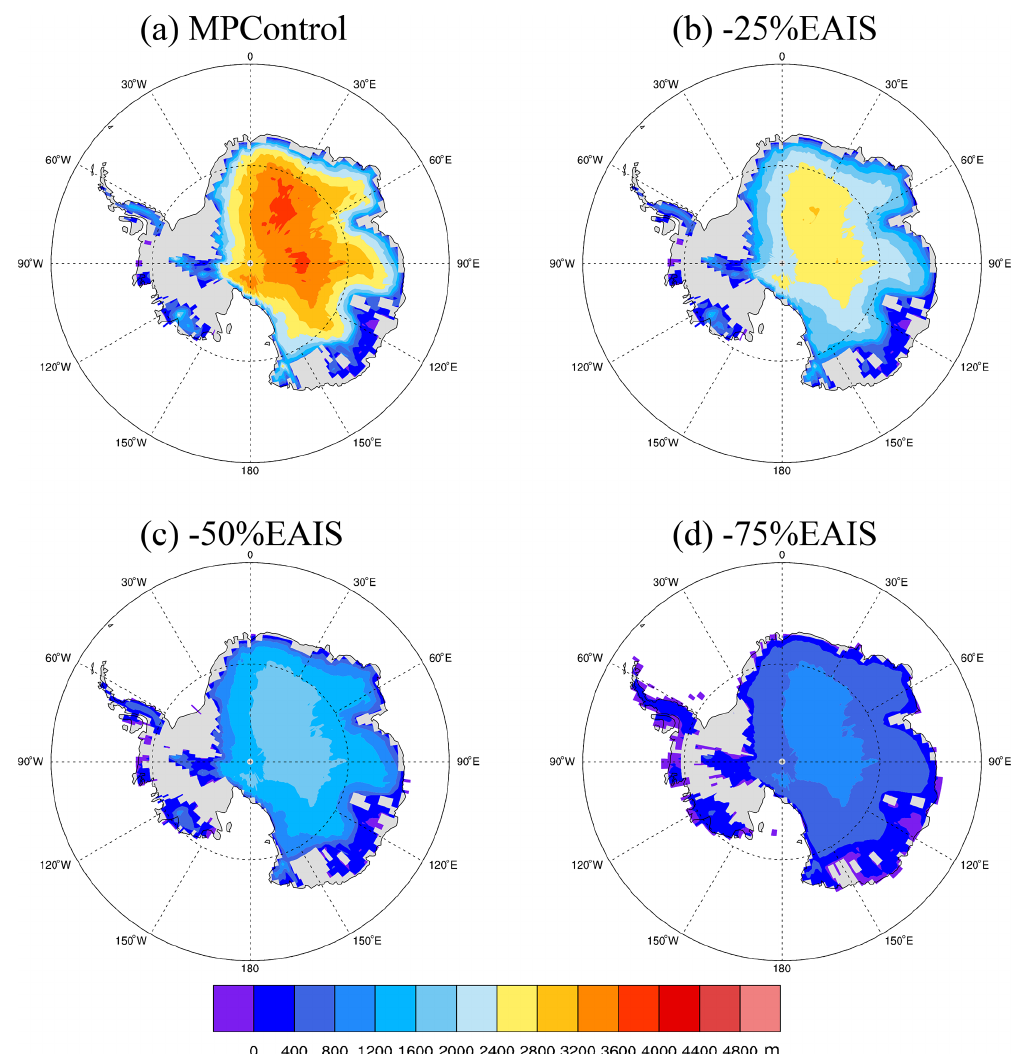
Figure 1. The height of the East Antarctic ice sheet for the (a) mid-Pliocene control experiment, (b) − 25%EAIS sensitivity experiment, (c) − 50% EAIS sensitivity experiment, and (d) − 75%EAIS sensitivity experiment. It should be noted that, for the − 100%EAIS sensitivity experiment, the height of the East Antarctic ice sheet has been set to zero, while the surface type is still